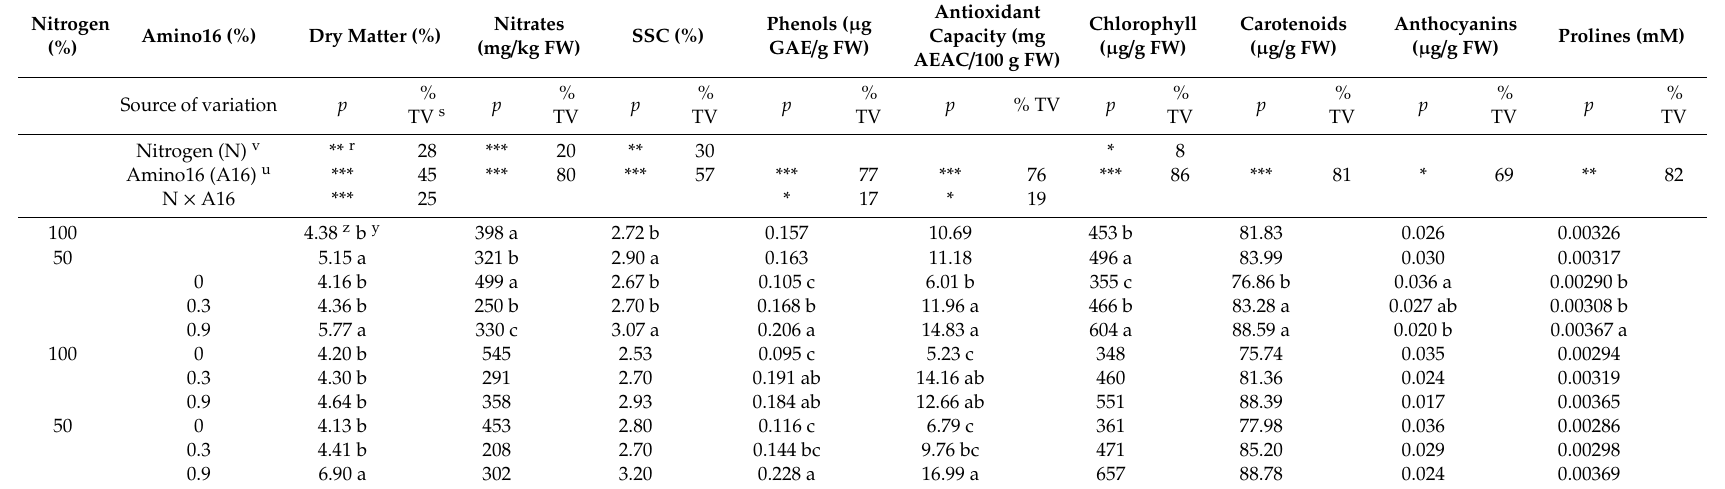
Table 5. Analysis of variance and mean comparison of dry matter, nitrate, soluble solid (SSC), phenolic, total chlorophyll, total carotenoid, anthocyanin, and proline content, as well as total antioxidant capacity of red baby lettuce grown in 131 (100%) or 65.5 mg / L (50%) N supplemented with 0, 0.3, or 0.9% Amino16 ® . Nitrogen